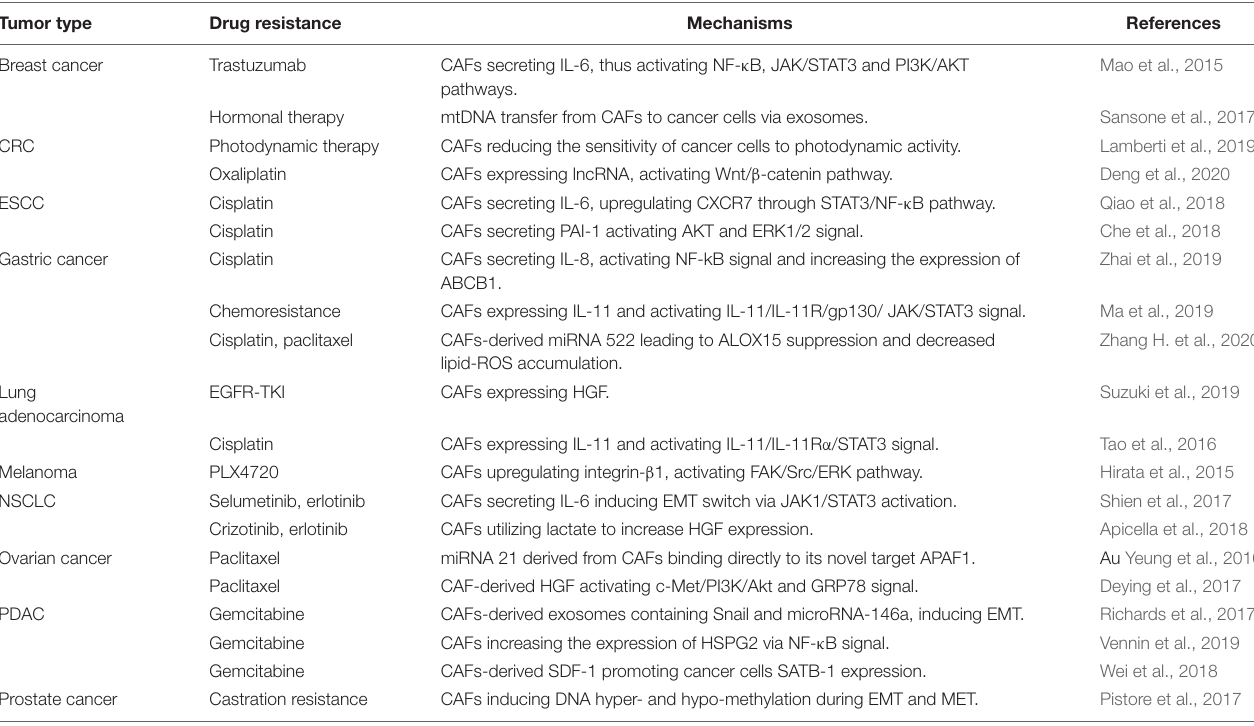
TABLE 1 | Mechanisms of antitumor drug resistance mediated by